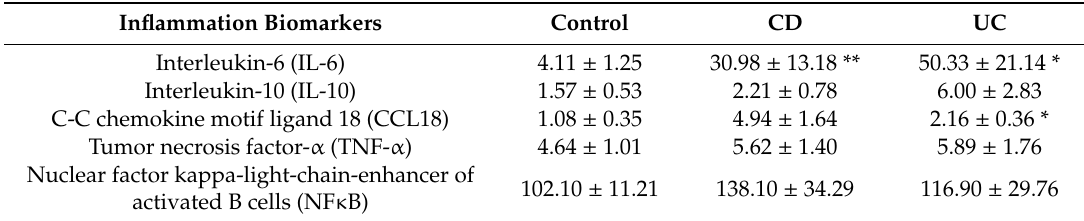
Table 2. Relative mRNA expression level of selected biomarkers of inflammation in control subjects and IBD patients enrolled in the